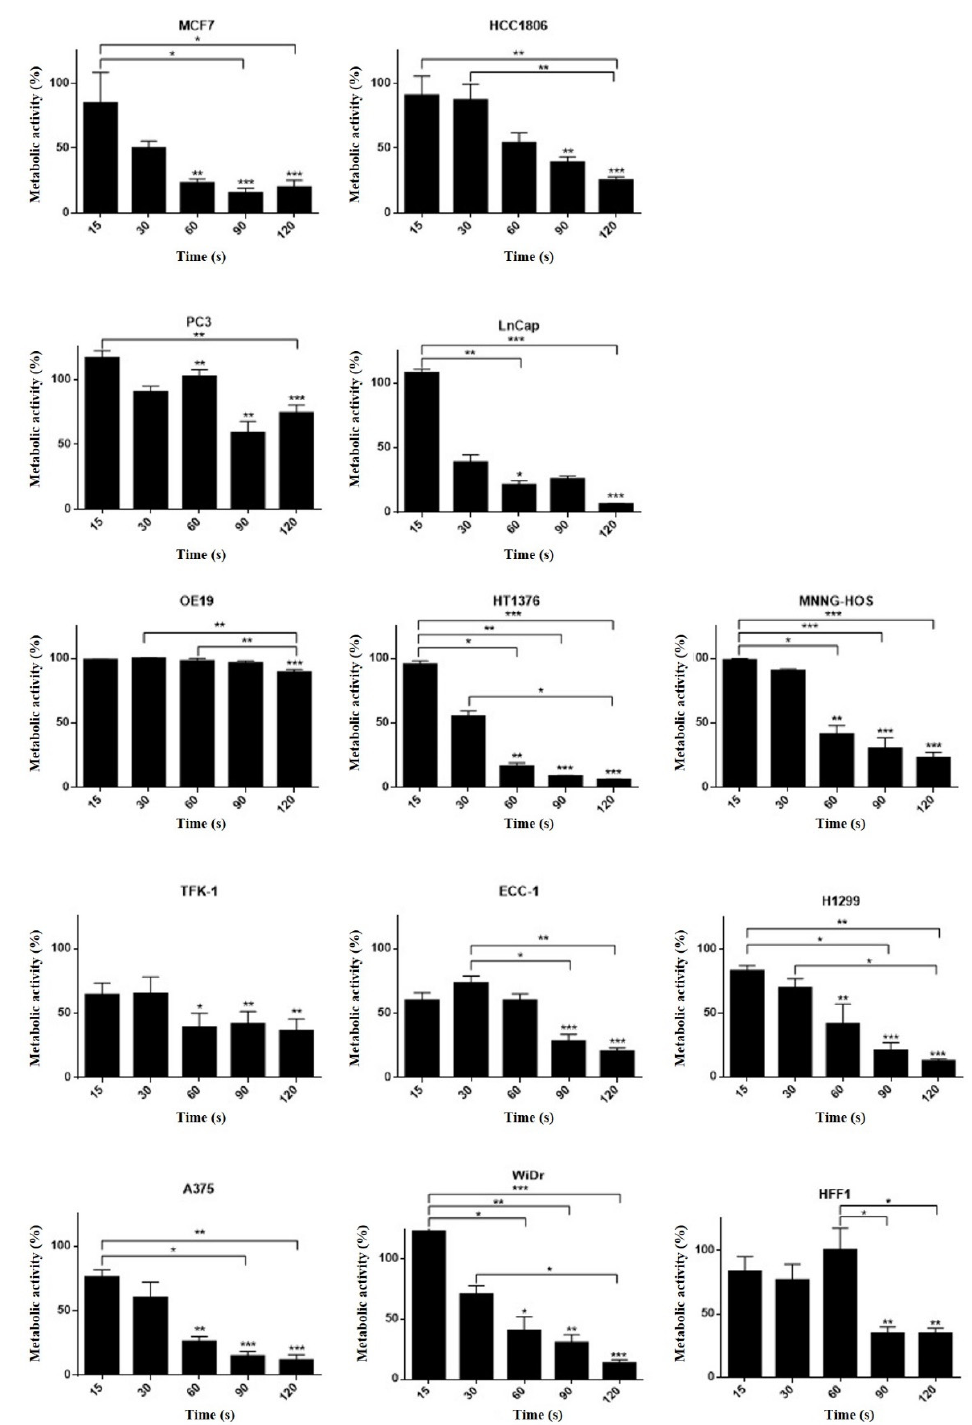
Figure A2. SRB assay results 24 h after plasma therapy application in different human cell lines: hormonal receptor positive breast cancer (MCF7), triple-negative breast cancer (HCC1806), prostate (PC3 and LnCap), esophageal adenocarcinoma (OE19), urinary bladder grade 3 carcinoma (HT1376), osteosarcoma (MNNG-HOS), extrahepatic bile duct carcinoma (TFK-1), endometrial cancer (ECC-1), lung cancer (H1299), melanoma (A375), colon carcinoma (WiDr), and fibroblast (HFF1) at distinct times: 15, 30, 60, 90, and 120 s. Results are expressed as the percentage of protein content normalized to control. Statistical significance in relation to control and between cell populations is represented as * for p < 0.05, ** for p < 0.01, and *** for p < 0.001 ( n = 9).